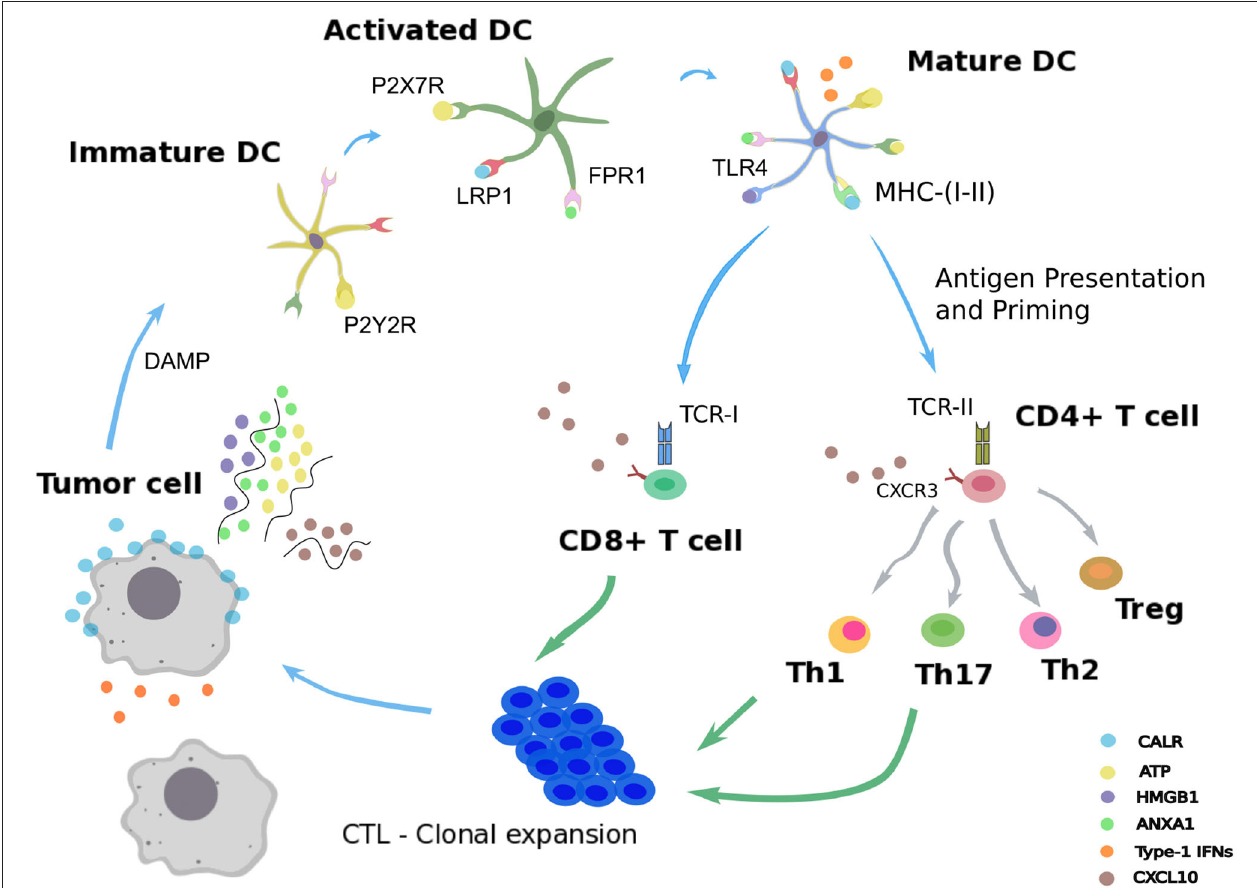
FIGURE 1 | Immunogenic cell death. Schematic representation of the immunogenic cell death cycle, starting with release of DAMPs from a dying tumor cell, leading to the maturation of a dendritic cell (DC), ultimately activating CD4 + and CD8 + T cells, which in turn trigger the death of the remaining live tumor